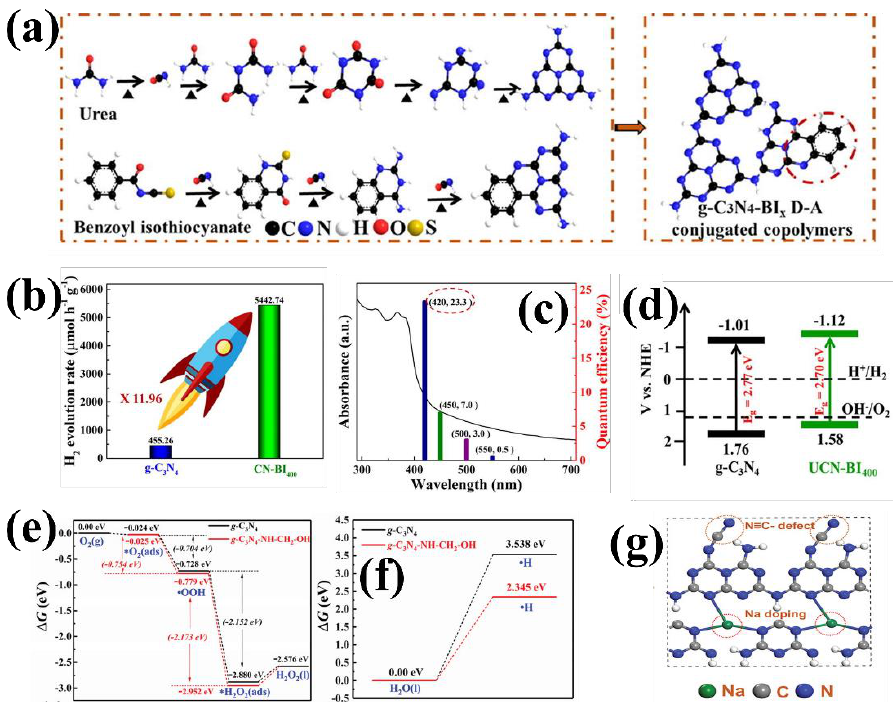
Figure 8. ( a ) Schematic illustration of the possible reaction path for fabrication of UCN-BIx D-A conjugated copolymers. ( b ) Photocatalytic H 2 evolution rate and ( c ) AQE of UCN-BI D-A conjugated copolymers. ( d ) Band alignment of pure g – C 3 N 4 and UCN-BI400 [90]. Free energy diagrams for ( e ) the reduction of O 2 to H 2 O 2 and ( f ) H 2 O dehydrogenation to •H on the pristine CN and g − C 3 N 4 − NH − CH 2 − OH [91]. ( g ) Schematic of proposed structure of CN with Na doping and N≡C defect [53].